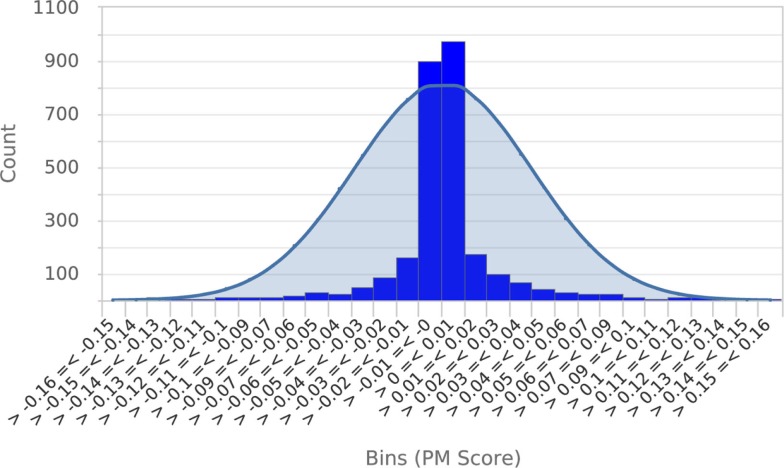
Null score distribution associated with 500 permutations of a typical query. To establish that the normal distribution was an appropriate model of the typical null score distribution, a histogram of scores obtained from 500 permutations of a typical query phenotype was prepared and overlaid with a plot of the normal distribution calculated from the mean and SD of scores. This clearly shows that the normal distribution is a conservative model of the null score distribution. Essentially identical results were obtained from permutations of four other metabolic phenotypes.